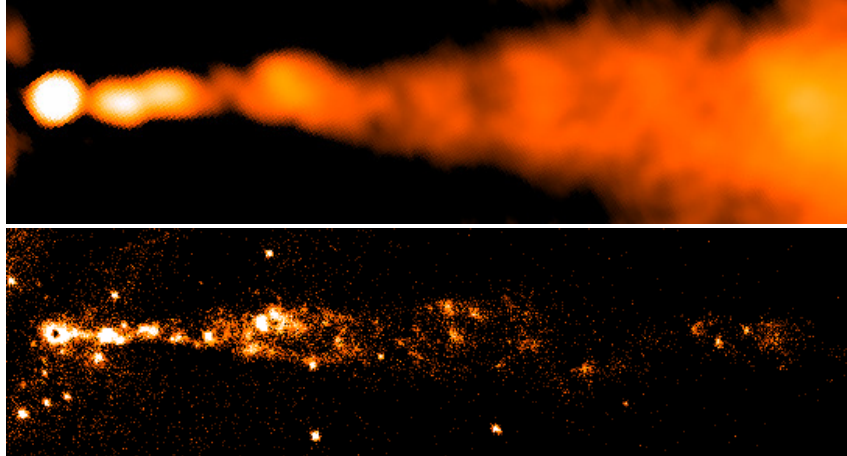
Figure 6. Centaurus A jet as observed by the VLA at 5 GHz and by Chandra at X-rays. Adapted from [138] (courtesy of Martin Hardcastle). The X-ray knottiness of this jet was interpreted as possible jet-massive star interactions. In the radio, the emission shows a diffuse